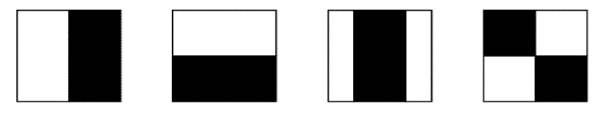
Fig. 2. Haar-like features used to detects patterns in images Integral image (summed-area table) is an algorithm that speeds up the calculation of the sum of pixel values in a specific area. To compute the integral image, each pixel in a given area only needs to be processed once, and there- fore only four numbers are